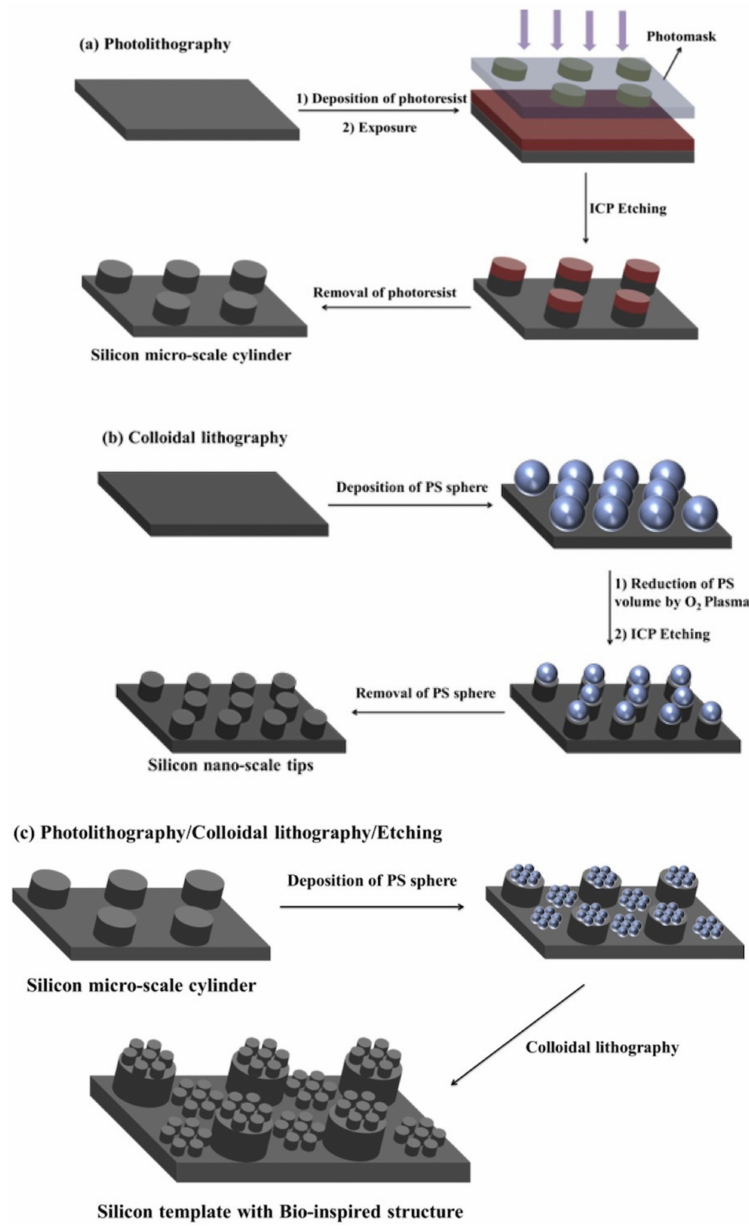
Figure 21. Schematic illustration of the fabrication of micro-, nano-, bio-inspired structures on a Si wafer hard template (Reprinted from [135] with permission from